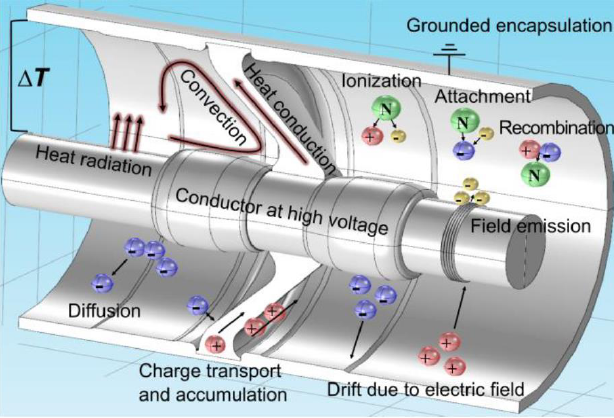
6 of 24 Table 1. Electric conductivity models considered for the electric field calculation. Insulation Domain